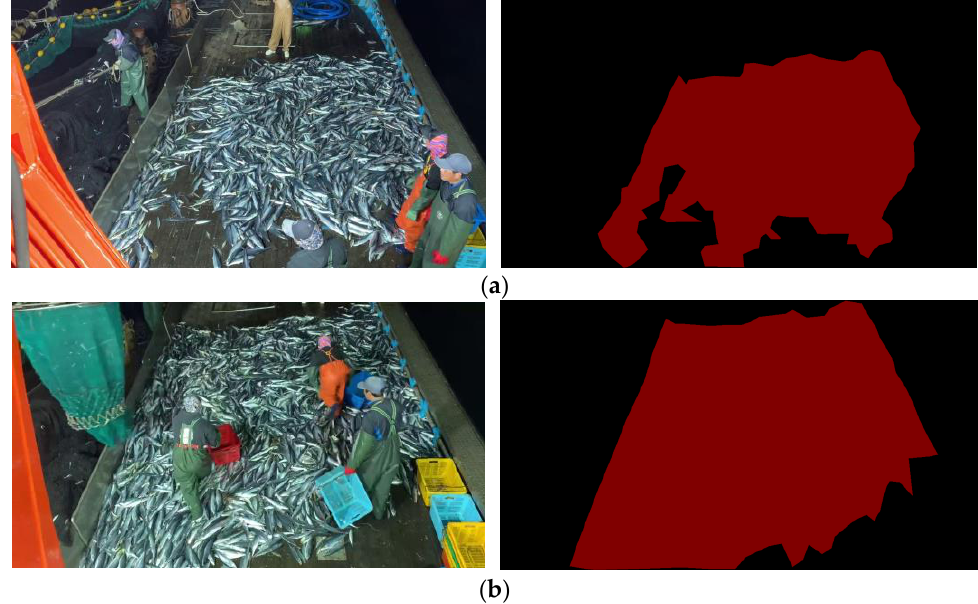
Figure 16. Example of pixel calculation for fish: ( a ) area — 320617, total — 921600, fish_area (%) — 34.789171006944447; ( b ) area — 475977, total — 921600, fish_area (%) — 51.64680989583333.